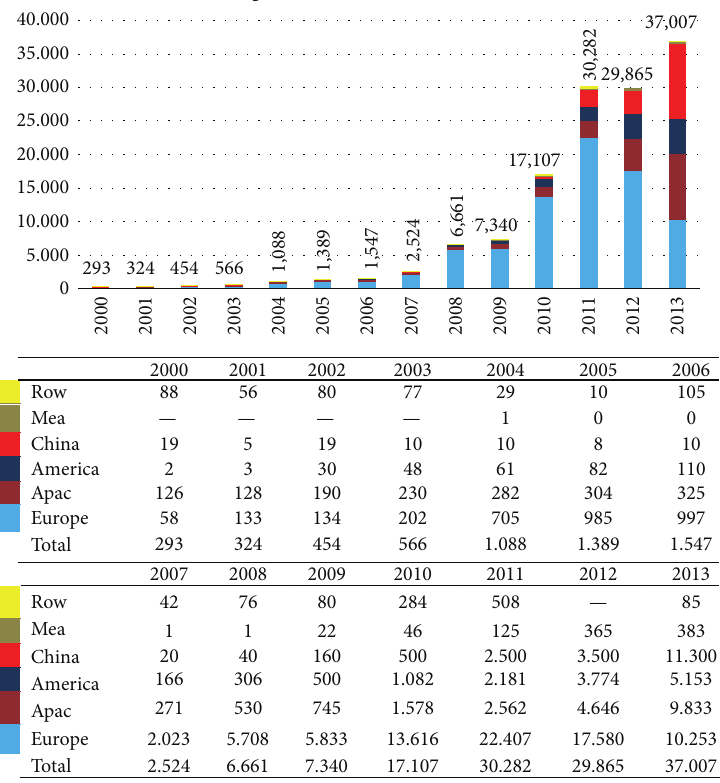
Figure 14: Annual installed capacity of photovoltaic electricity generation throughout the world